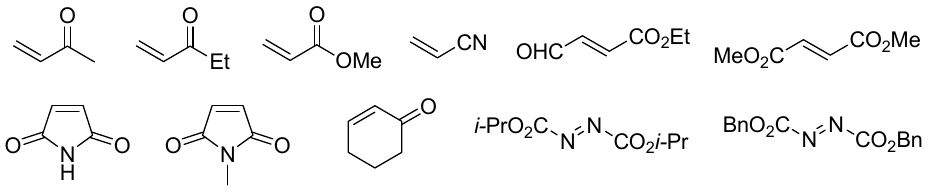
Figure 4. Diverse dienophile reagents for the Diels-Alder